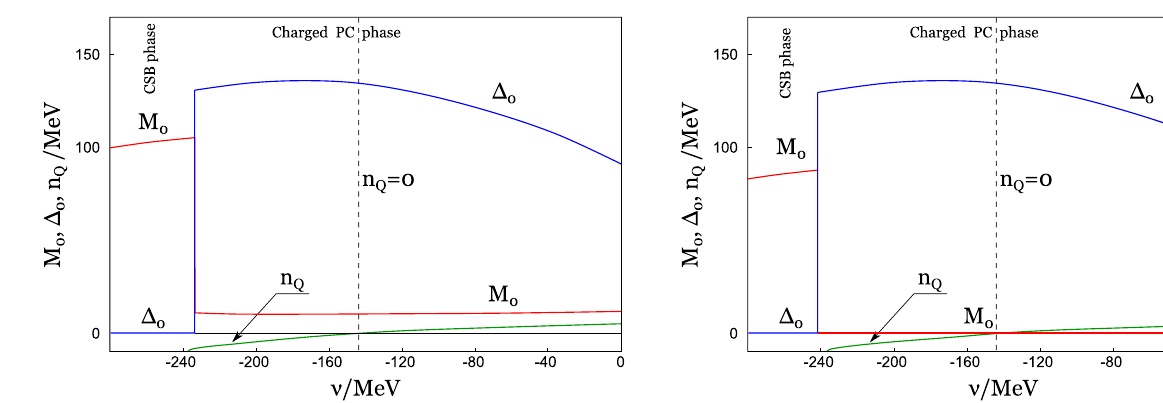
plots of the same quantities vs ν are presented at the same , μ μ, ν 5 5 -chemical potential values, but in the chiral limit.